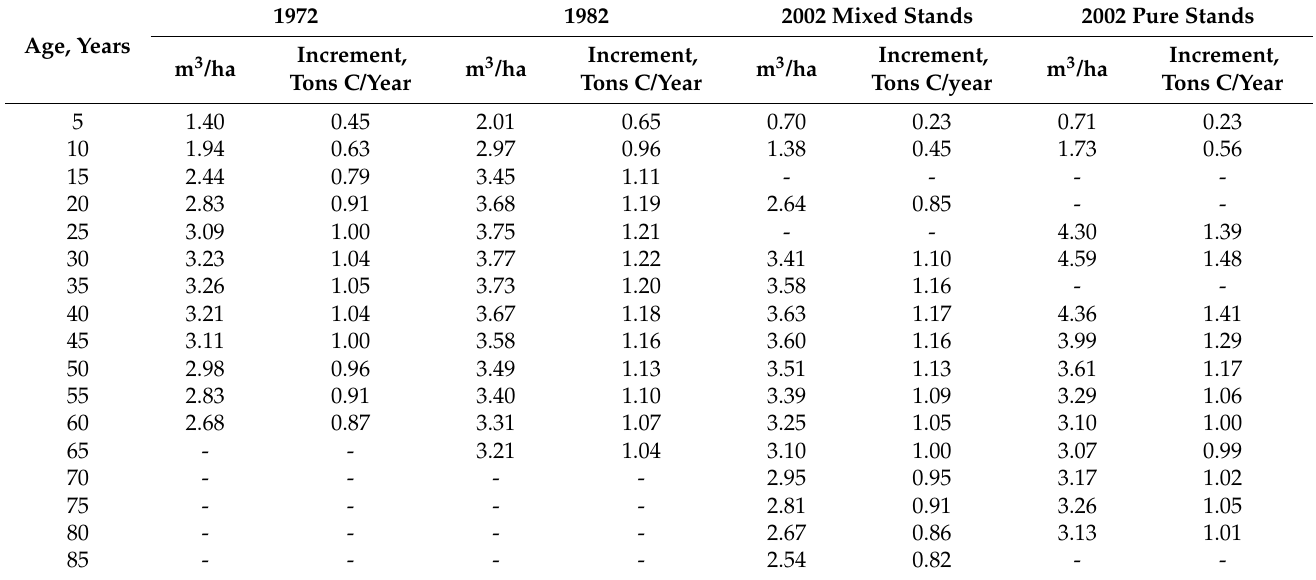
Table 2. Average annual carbon stock increment in living biomass (tons C/ha per year) by aspen forests’ age and inventory periods.